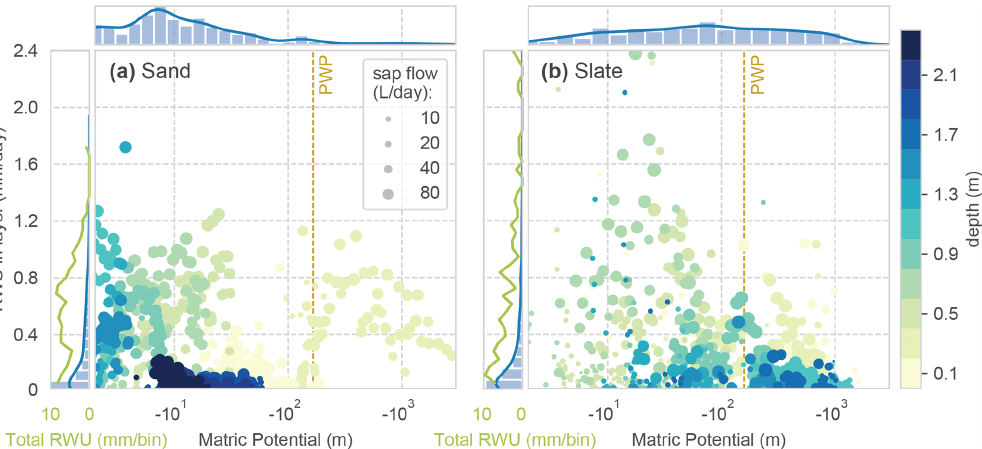
Figure C2. Sourcing of RWU. Daily values of matric potential in each soil layer and RWU; colour coding with respective depth. Dot size marks the reference SF of the day. The marginal histograms and kernel density distributions on top refer to the occurrence of the respective matric potential bin in the observed period. The marginals on the left give the distribution of RWU (blue) and the total RWU of a certain bin (green). The wilting point (PWP) marks a matric potential at the wilting point, with 4.2pF (161.6m H 2